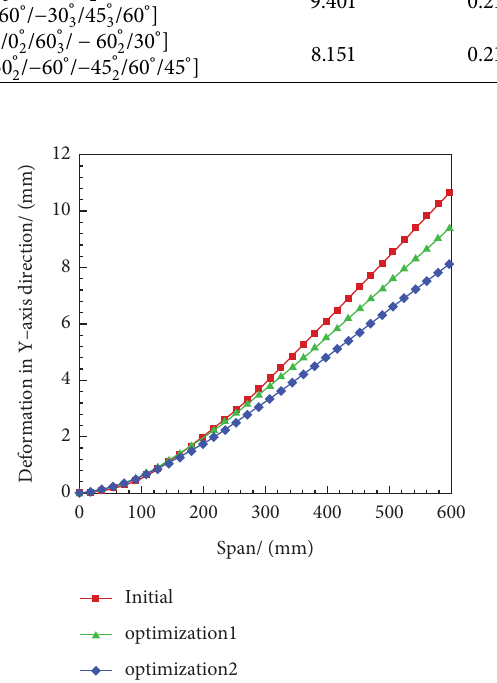
Figure 10: Deformation in Y -axis